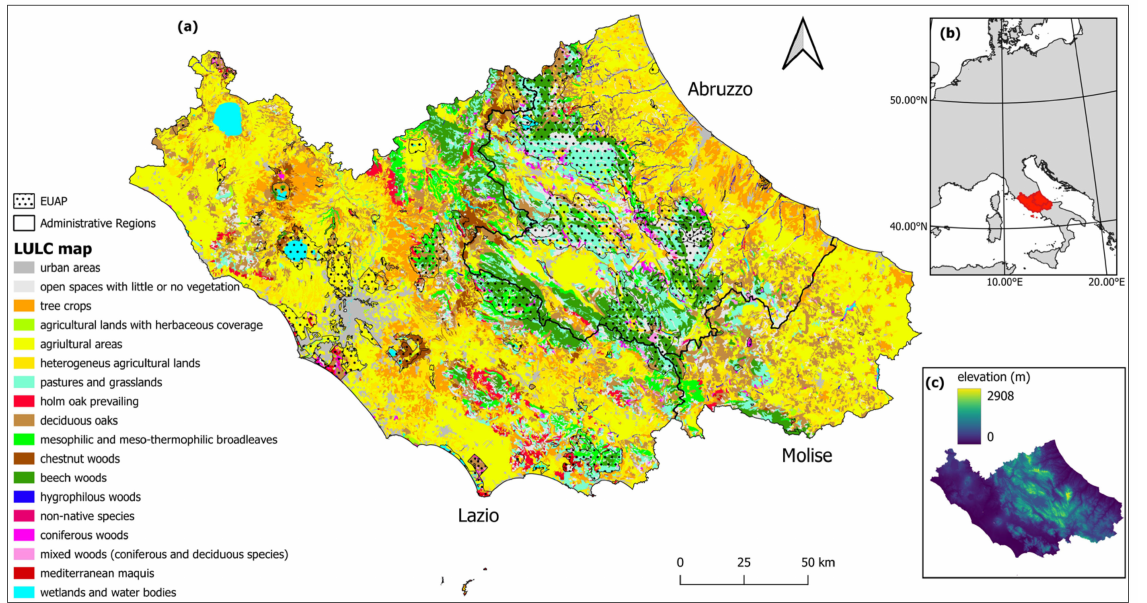
Figure 1. Land use and land cover map of the study area ( a ); the administrative regions’ borders are marked in black, and EUAP areas are dotted. The location of the study area ( b ) and the digital elevation model ( c ) are also